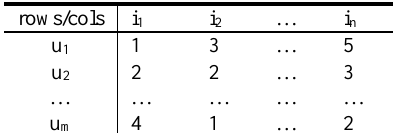
Table 1. Multi-criteria matrix: rows and columns